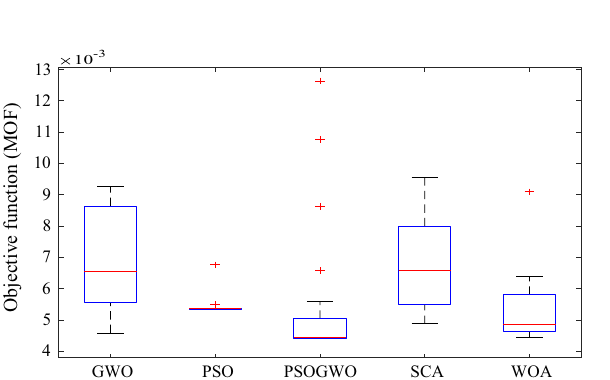
Figure 10. Boxplot of MOF using different